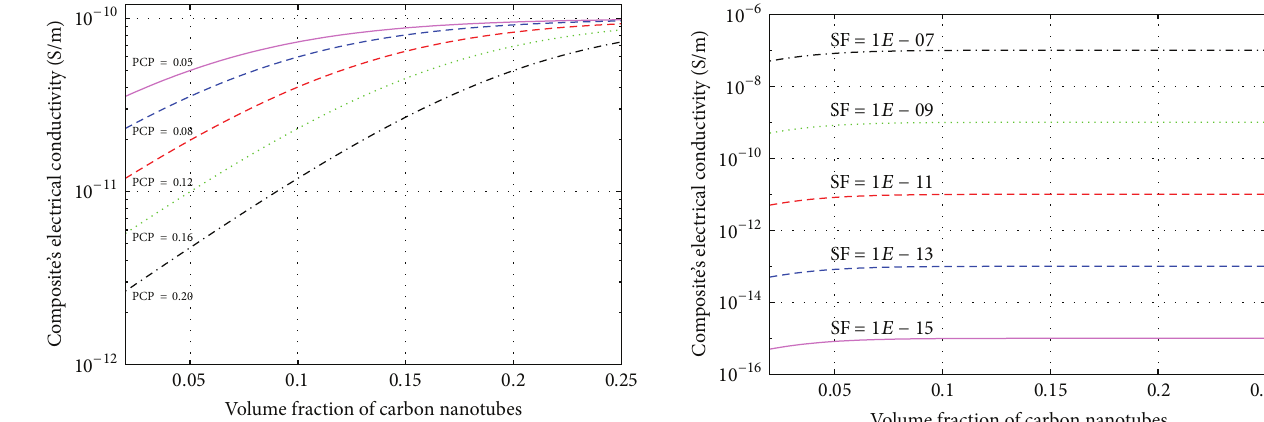
Figure 23: DC electrical conductivity of the nanocomposite at varying the conductivity of the filler (Sigmoidal function model).